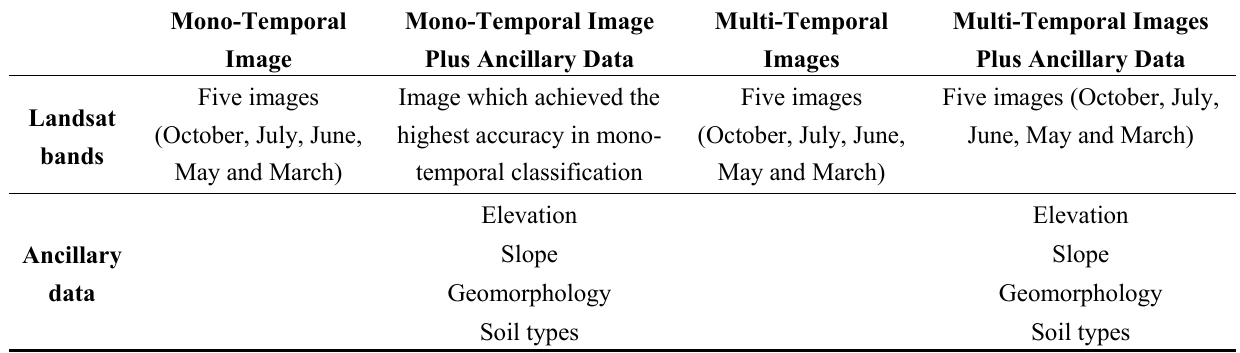
Table 5. Different approaches of image combinations used for the year